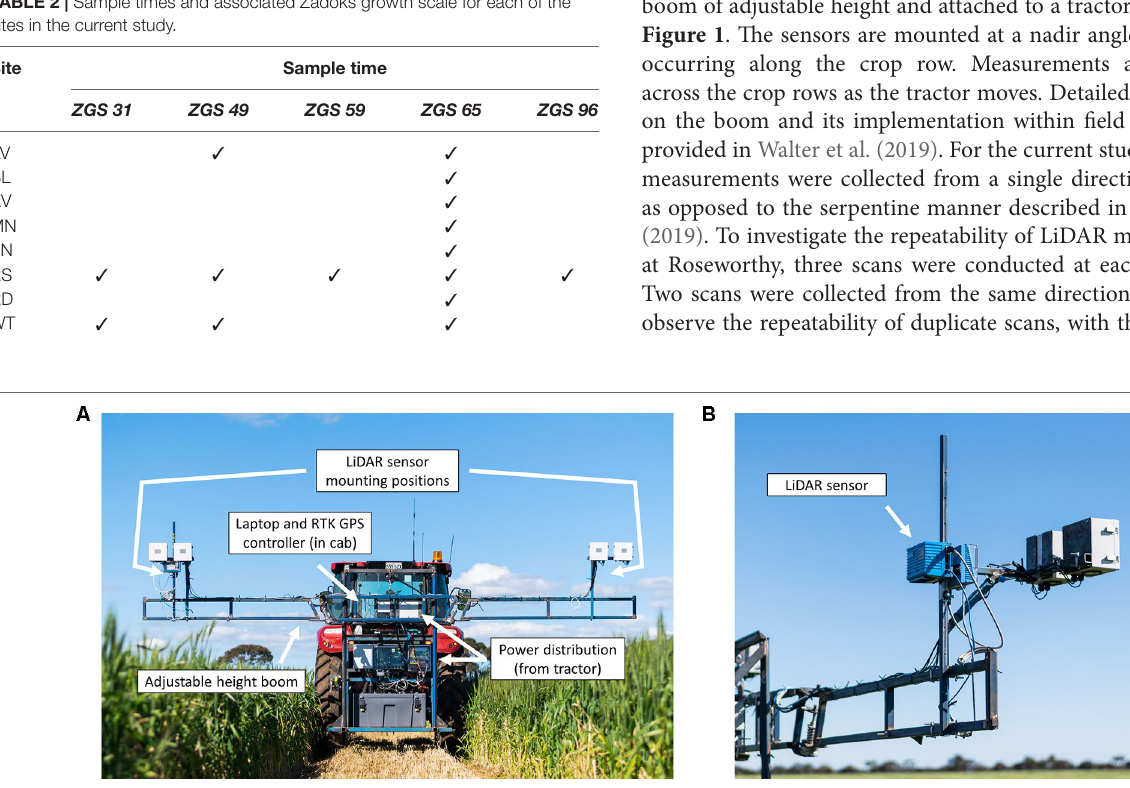
FIGURE 1 | The tractor mounted LiDAR system used in the current study showing the boom system and LiDAR sensor mounting positions, with major components annotated (A) and a closer view of one of the mounted LiDAR sensors (B)